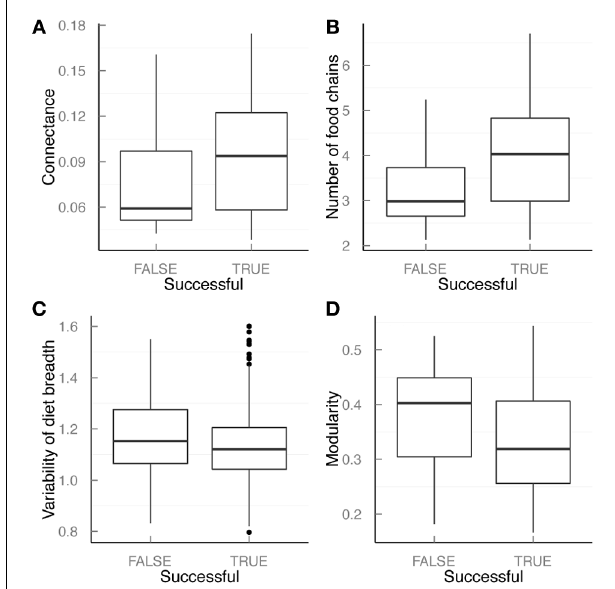
FIGURE 2 | Relationship between food web properties and invasion success. In each panel, box plots correspond to the median value and the first (bottom of the box) and third (top of the box) quartiles of the distribution of each network property: (A) connectance ( C = L / S 2 ), (B) Number of food chains (log(ChnNo)), (C) Standard deviation of generality (GenSD),and (D) modularity. In each panel, values of each property in communities with successful (True) and unsuccessful (False) invasions are